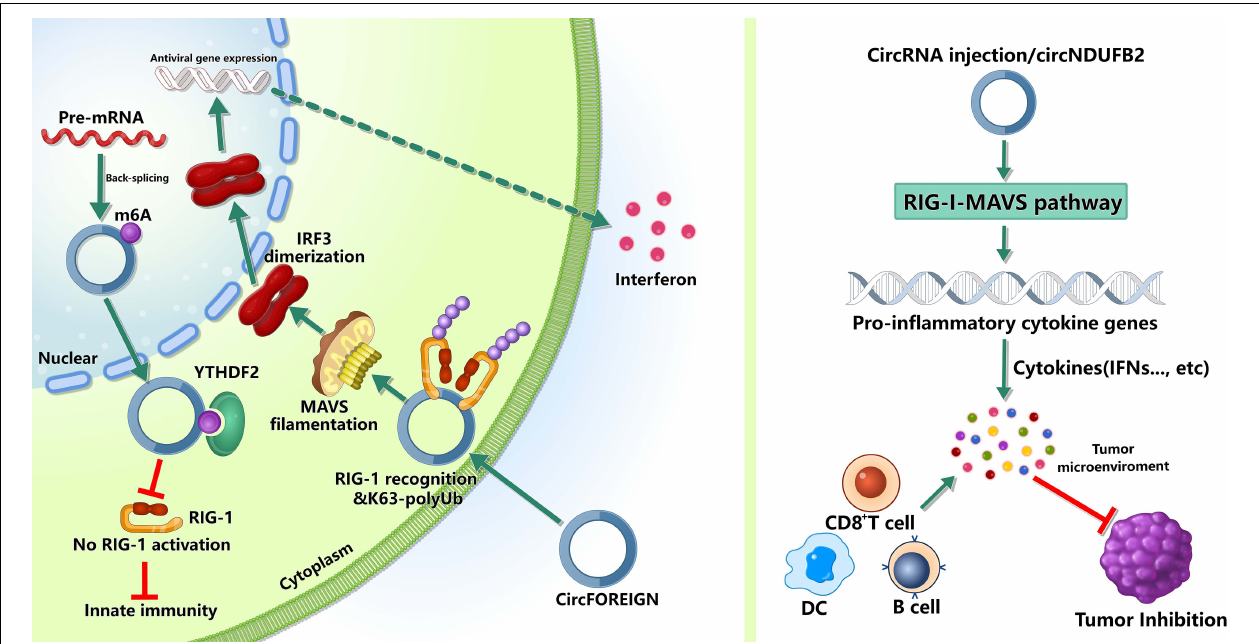
FIGURE 2 | Roles of m6A-modified circRNAs in immunity. m6A can mark “self” circRNAs and these endogenous circRNAs inhibite innate immune responses, whereas exogenous circRNAs can activate innate immunity by activating RIG-I in the presence of K63-polyubiquitin. In tumor immunity, circRNAs may inhibit tumor progression by inducing anti-tumor